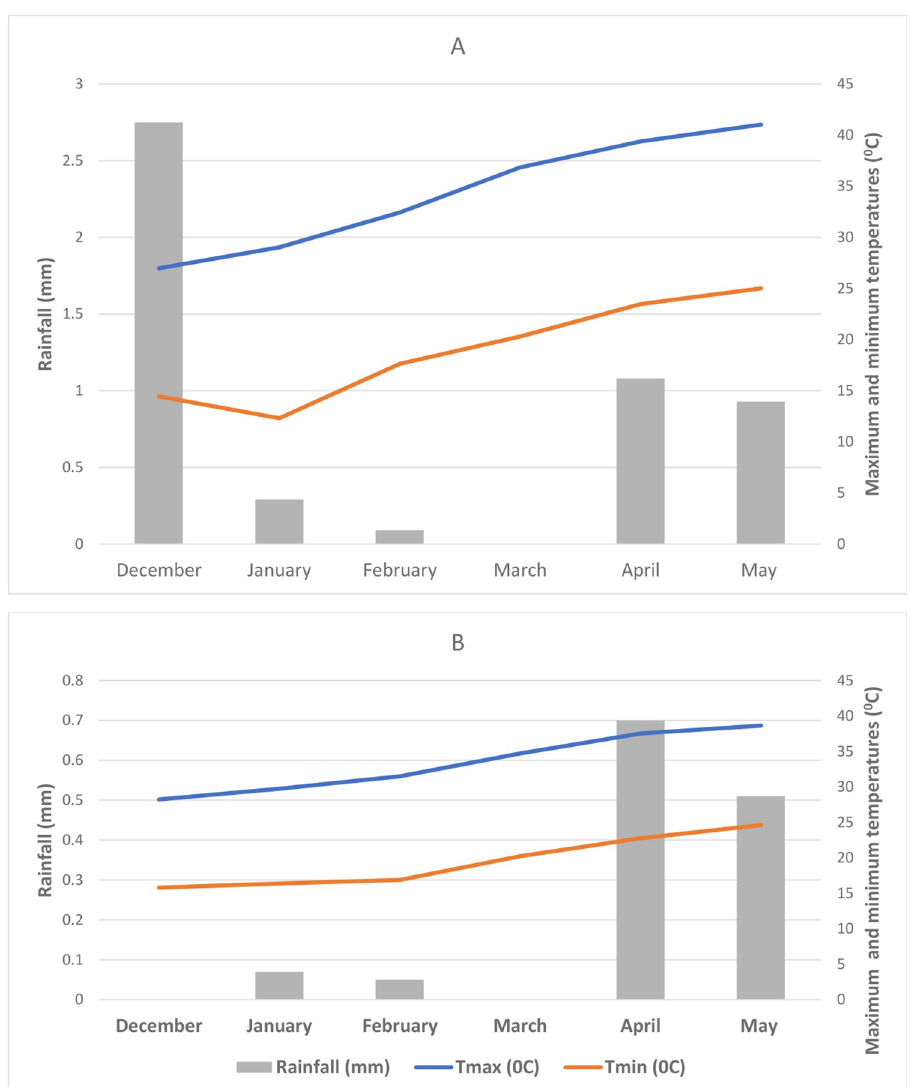
Fig 1. Monthly weather data during the field trial at ICRISAT/India during (A) 2018/19 and (B) 2019/20 post- rainy seasons. Plant height (PH, expressed in cm) was measured from ten randomly sampled and tagged plants from the soil surface to the tip of the main stem. The number of primary branches (PB) was recorded as the average number of primary branches from the ten plants. Pod yield per plant (PY, expressed in g plant -1 ) was recorded as the average pod weight of ten sample plants. Pods of each genotype were assorted using a sieve and size ranges between 6 to 8mm were selected. A random sample of pods weighing 200g was used to calculate shelling percentage which was a proportion of shelled seed weight to the unshelled pods. Seed yield per plant (SY, expressed in g plant -1 ) was estimated as the product of pod yield per plant and shelling per- centage. Total biomass per plant (TBM, expressed in g plant -1 ) was recorded as the mean total biomass weight of ten sample plants during the physiological maturity of the crop. Harvest index (HI) was computed as a ratio of pod weight to total biomass [43].